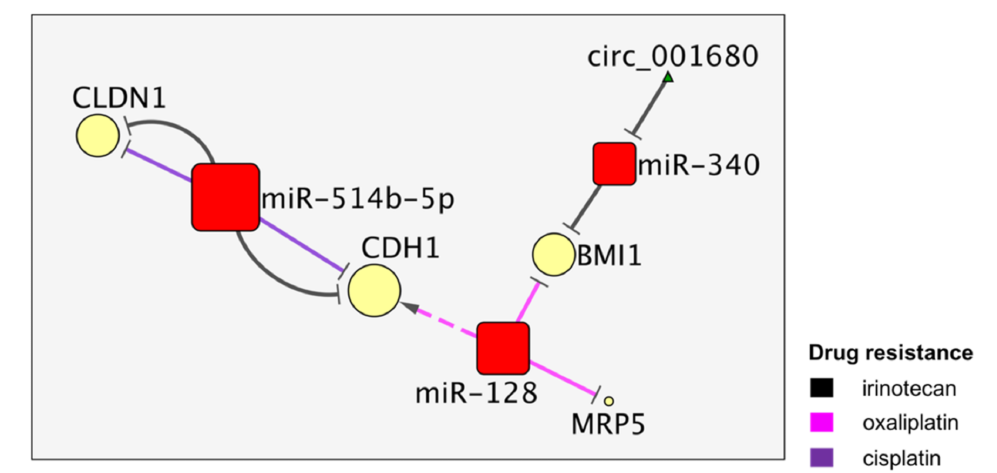
Figure 4. The miR-514b and miR128 microRNA niches are connected by CDH1. Ren et al. investigated the antagonist effects of the miR-514b-5p and miR-514b-3p products, respectively, a promoter and suppressor of metastasis, EMT and CPT11/CDDP resistance, by regulating cadherin 1 ( CDH1 ) and claudin 1 ( CLDN ), the targets of miR- 514b-5p, frizzled class receptor 4 ( FZD4 ) and netrin 1 ( NTN1 ), the targets of